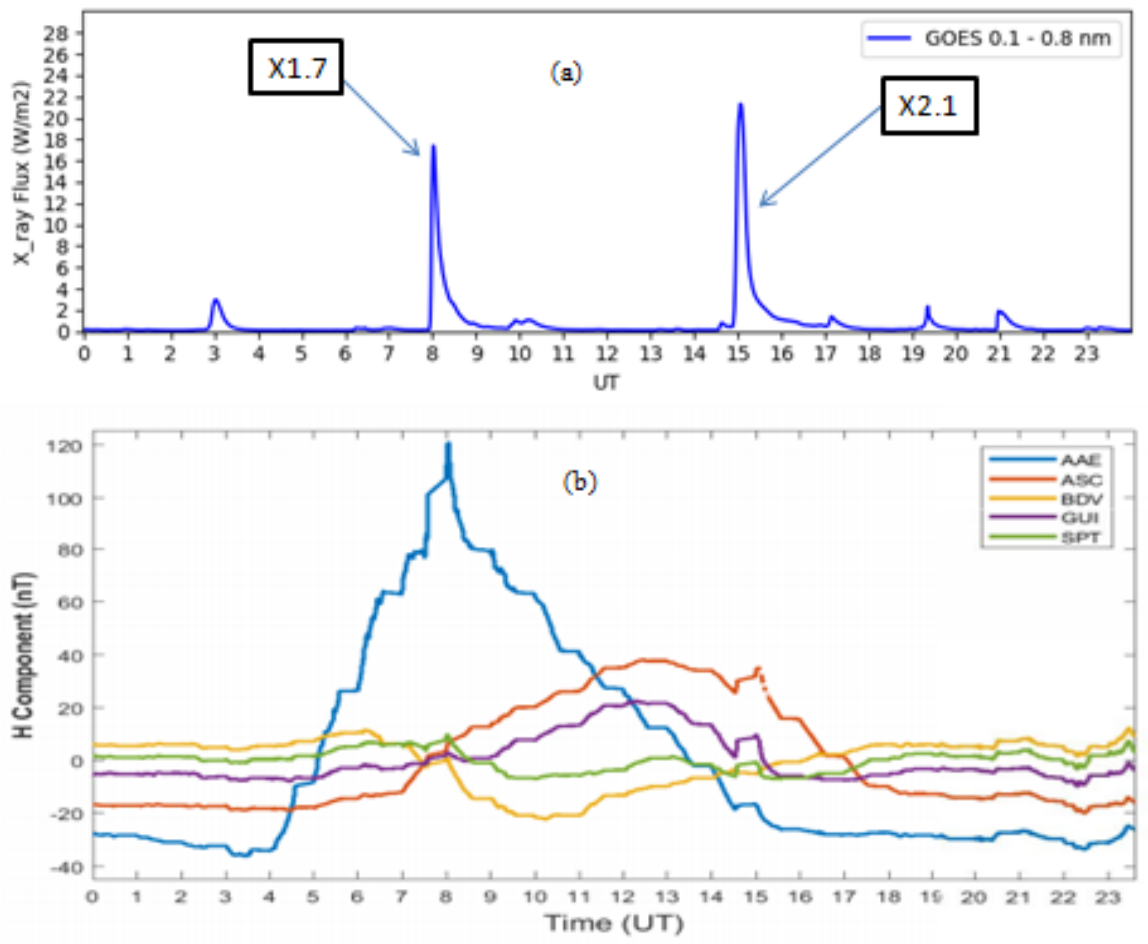
Figure 11. ( a ) Magnetic effects of the X1.7 and X2.1 solar flares of 25 October 2013, and ( b ) on the H component at different observatories. Table 8. Summary synthesis of all class study.